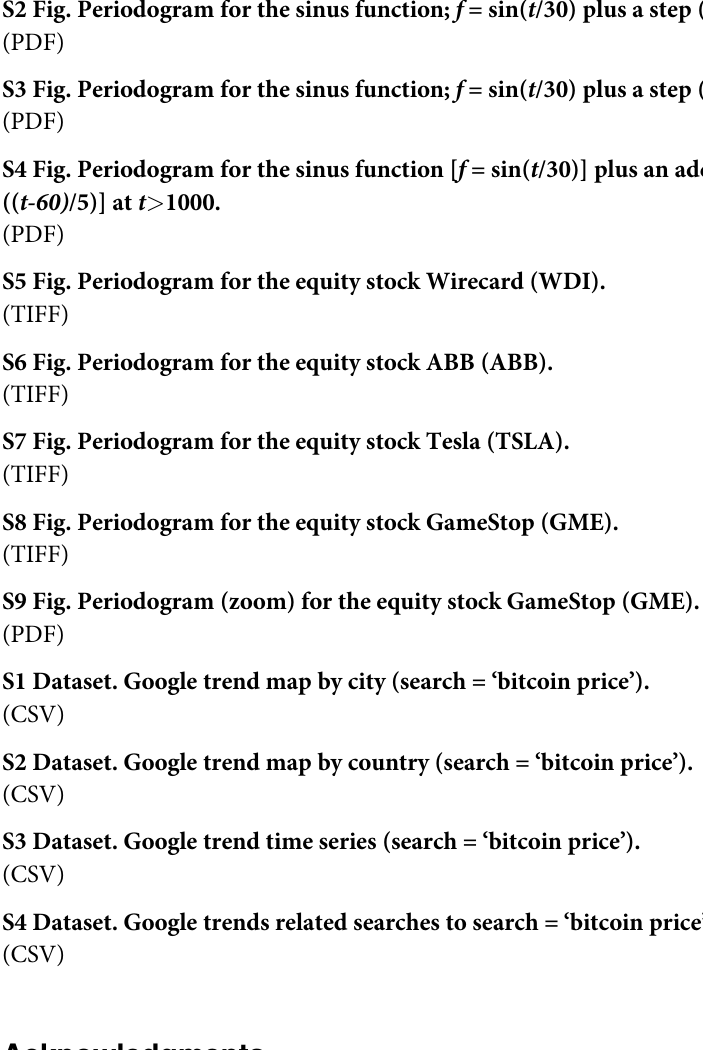
S1 Fig. Periodogram for the sinus function; f = sin(t/30). S2 Fig. Periodogram for the sinus function; f = sin( t /30) plus a step ( dz = 0.1) at t > 1000. S3 Fig. Periodogram for the sinus function; f = sin( t /30) plus a step ( dz = 1.5) at t > 1000. S4 Fig. Periodogram for the sinus function [ f = sin( t /30)] plus an additional sinus [ f = sin (( t-60) /5)] at t > 1000. S5 Fig. Periodogram for the equity stock Wirecard (WDI). S6 Fig. Periodogram for the equity stock ABB (ABB). S7 Fig. Periodogram for the equity stock Tesla (TSLA). S8 Fig. Periodogram for the equity stock GameStop (GME). S9 Fig. Periodogram (zoom) for the equity stock GameStop